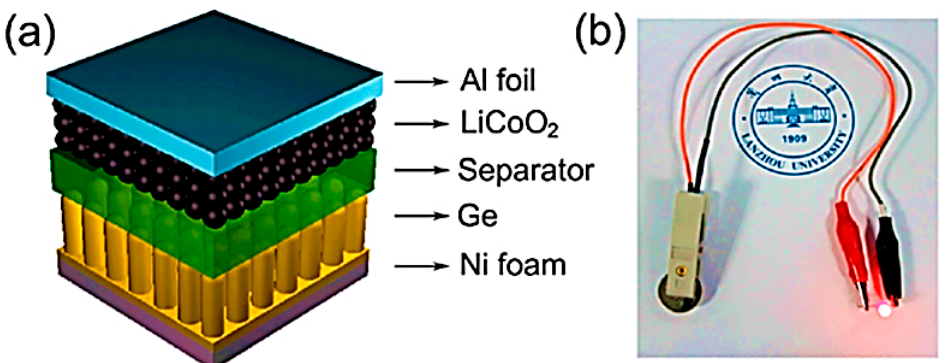
Figure 13. ( a ) Schematic of the Ge / LCO full-cell. ( b ) Digital image of a light-emitting diode lighted by the Ge / LCO full-cell.